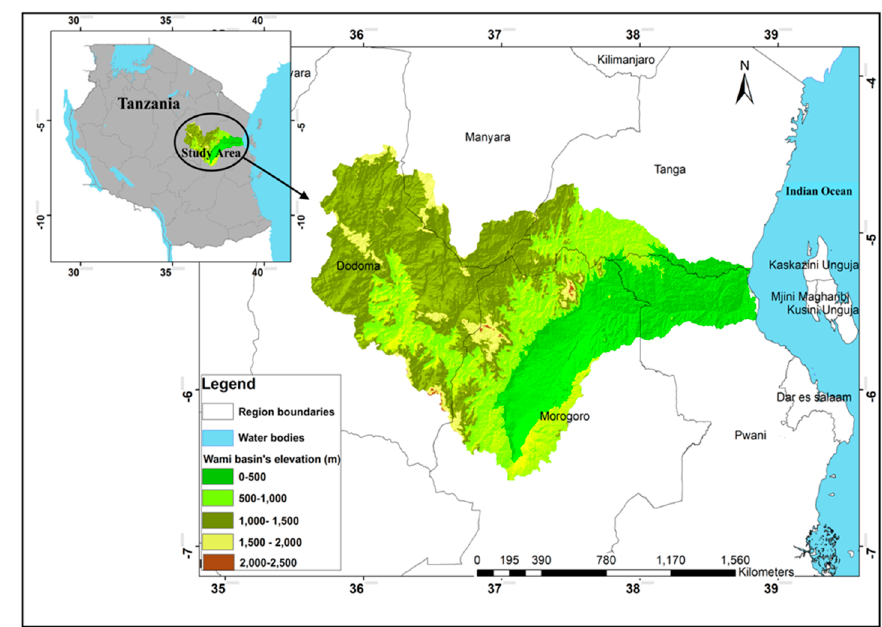
Figure 1. The study area of Wami River Basin.